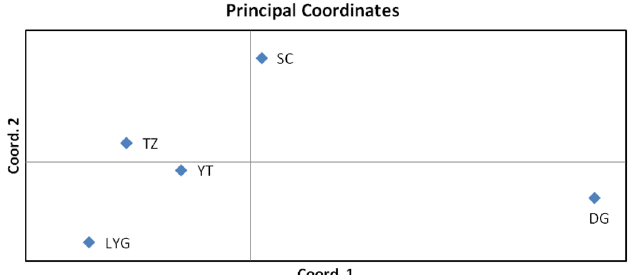
Fig. 2. Principal component analysis (PCA) of the fi ve populations of Larimichthys polyactis .